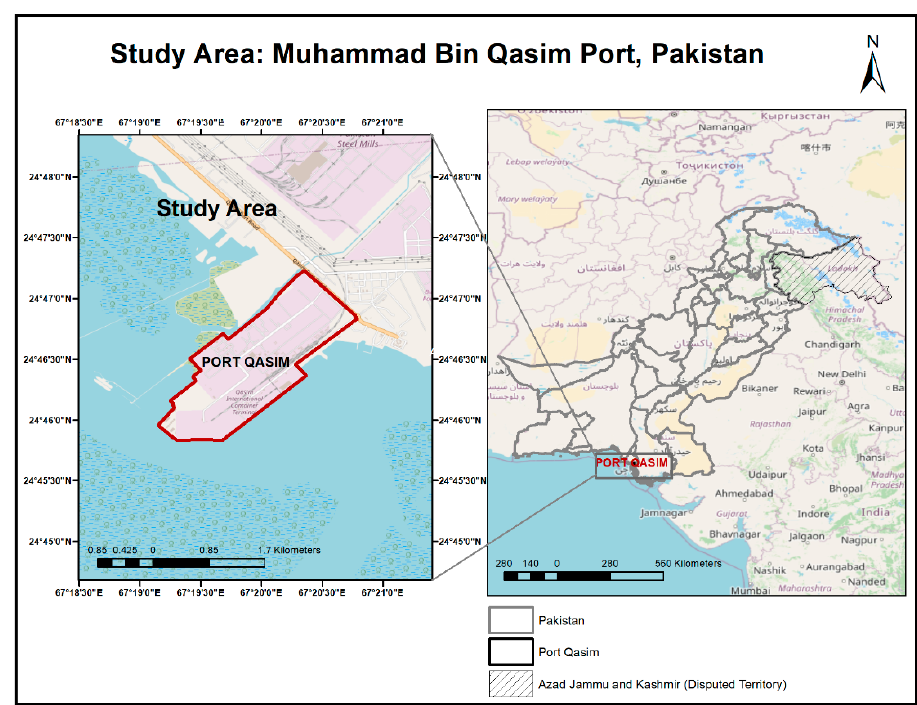
Figure 1. Study area, Muhammad Bin Qasim Port, Pakistan.